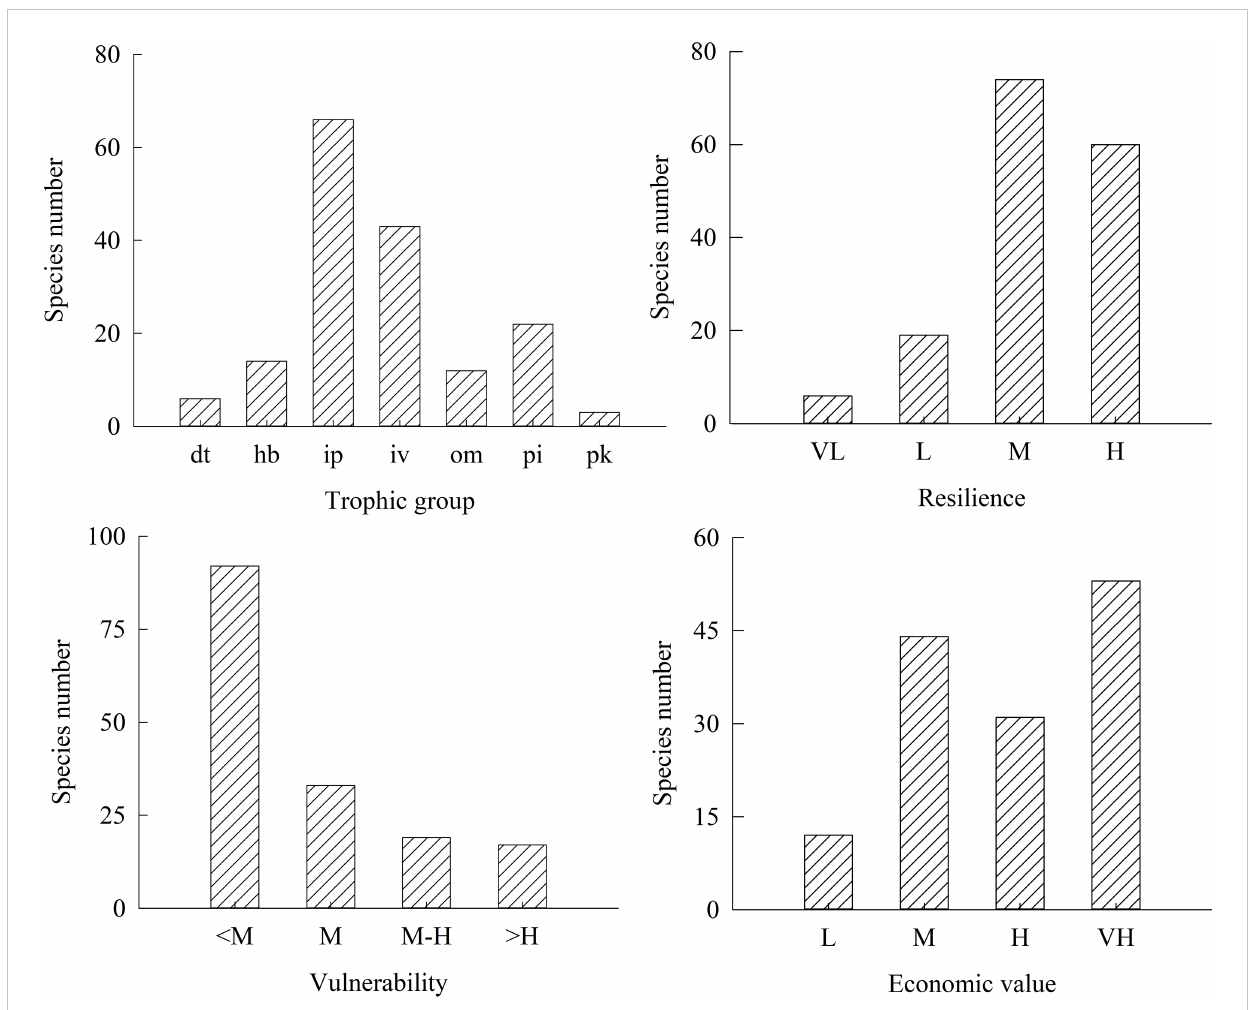
FIGURE 2 Number of fi sh species for different diet, vulnerability, resilience and economic value in the lagoon of Meiji Reef in the South China Sea. The dt, hb, ip, iv, om, pi and pk mean detritivores, herbivores, piscivores, invertebrate feeders, omnivores, invertebrate feeder & piscivores, and planktivores, respectively. The VL, L, M, M-H, H, and VH mean very low, low, moderate, moderate-high, high, and very high levels,